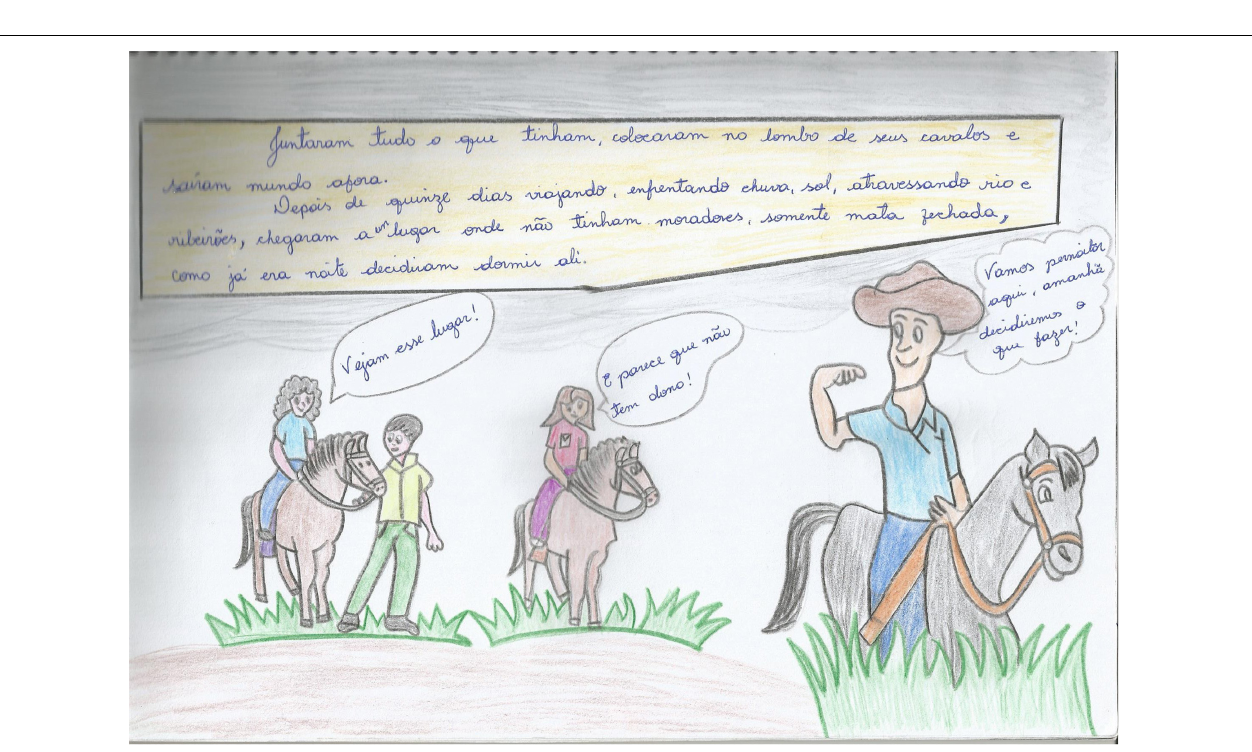
FIGURE 2 | Excerpt from a comic produced by student S1 (source: Elaborated by student